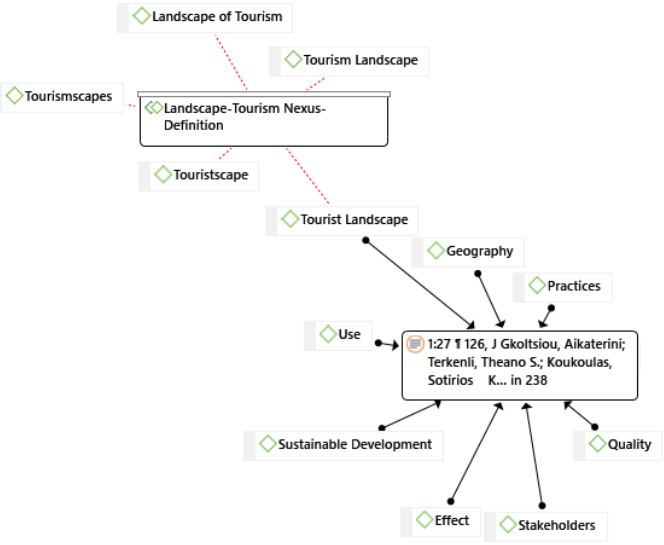
Figure 9. Linkages between publication 1, definitional aspects, and codes by ATLAS.ti. The figure shows a publication where “tourist landscape” was used to embrace different conceptual codes from “Planning” to “Practices” and to “Effect”.